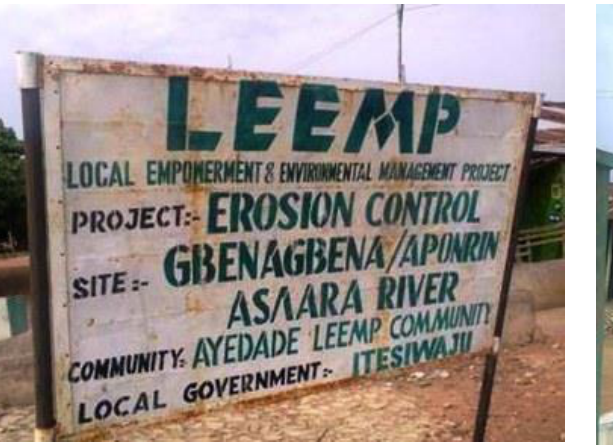
Fig. 7. Signpost of Erosion Control Project Fig. 8. Areal View of Ipapo